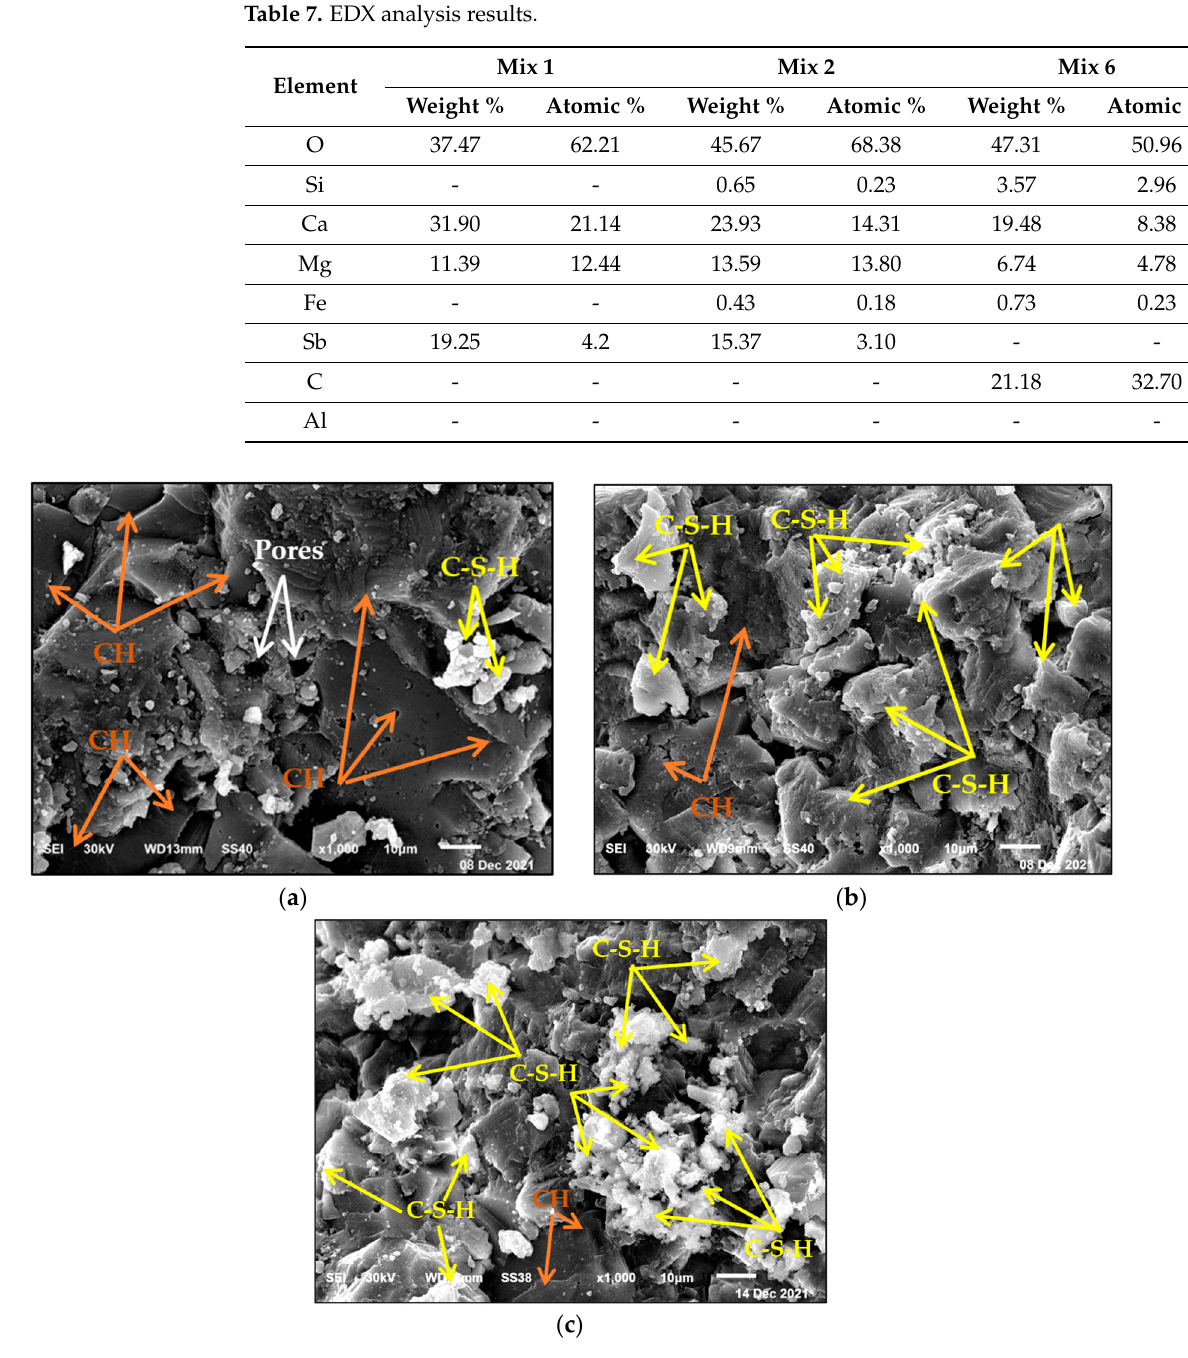
Figure 10. SEM images of mixes 1, 2, and 6. ( a ) Mix 1 (TW, no SF); ( b ) Mix 2 (TW, SF); ( c ) Mix 6 (MW, SF). (MW,